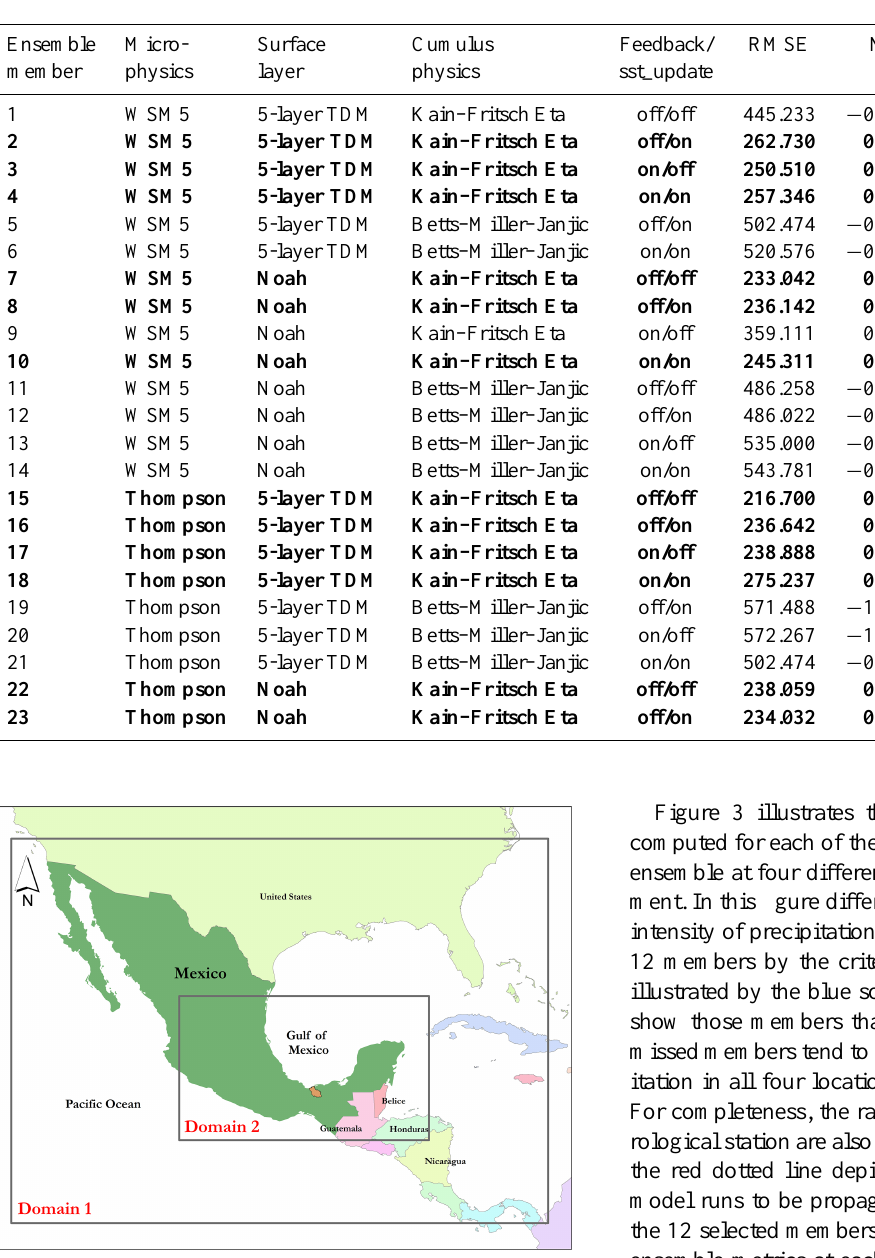
Table 1. Ensemble members defined for the multi-physics WRF ensemble (rows in bold indicate selected members; TDM – Thermal Diffu- sion Land Surface Model).